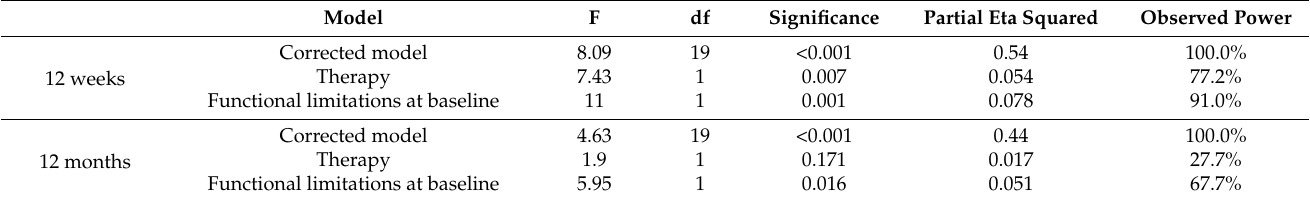
Table 2. Tests of between-subject effects with dependent variable: changes in WOMAC Index from baseline to 12 weeks and to 12 months. Therapy, gender, and patients’ expectations for therapy re- ceived were fixed factors; and WOMAC-A (pain), WOMAC-B (stiffness), and WOMAC-C (functional limitations), all three at baseline, were